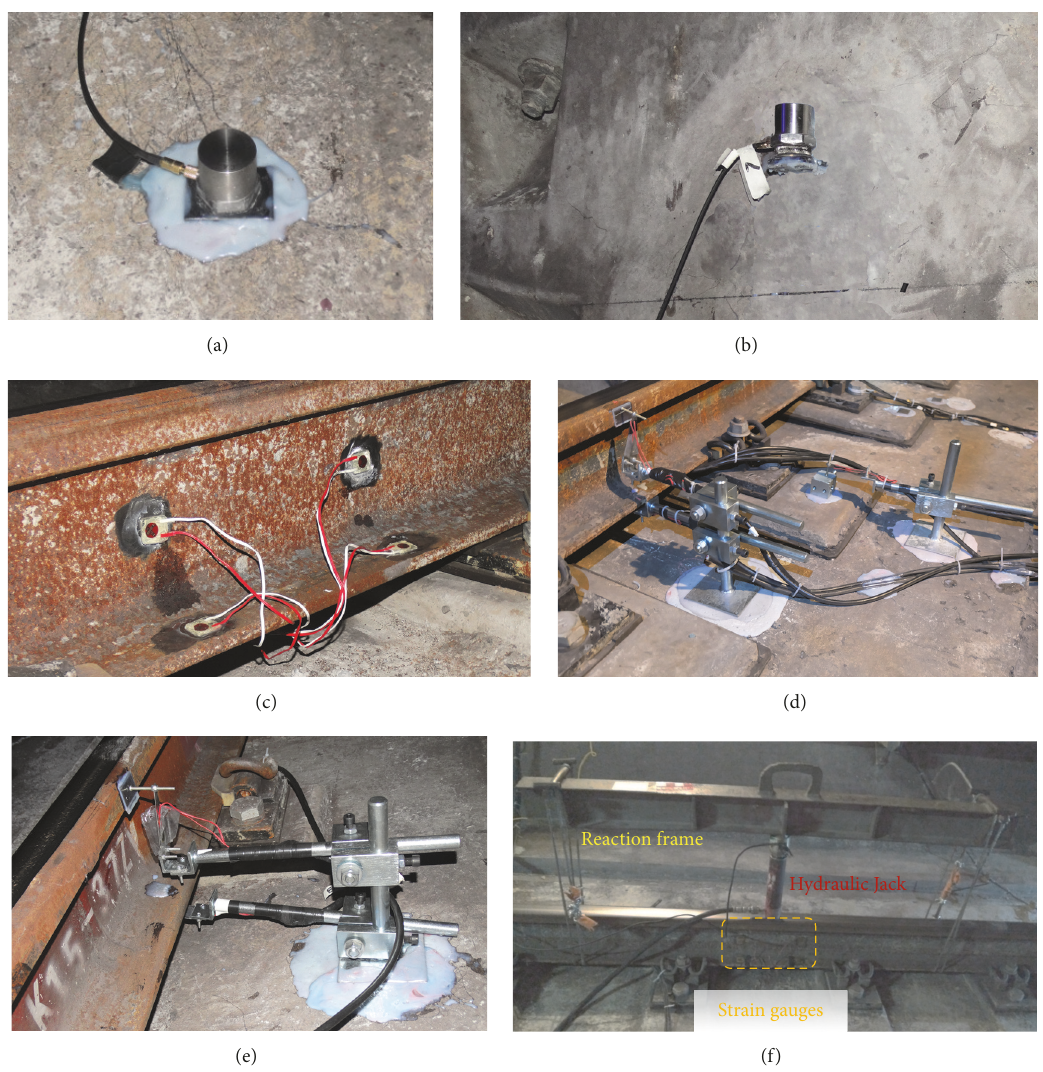
Figure 6: Field installation of sensors and calibration. (a) Acceleration sensor of track bed; (b) acceleration sensor of tunnel wall; (c) wheel- rail force strain gauges; (d) test device for vertical displacements of the rail and sleeper in LEST; (e) test device for vertical displacements of the rail in common ballastless track; (f) vertical wheel-rail force calibration.